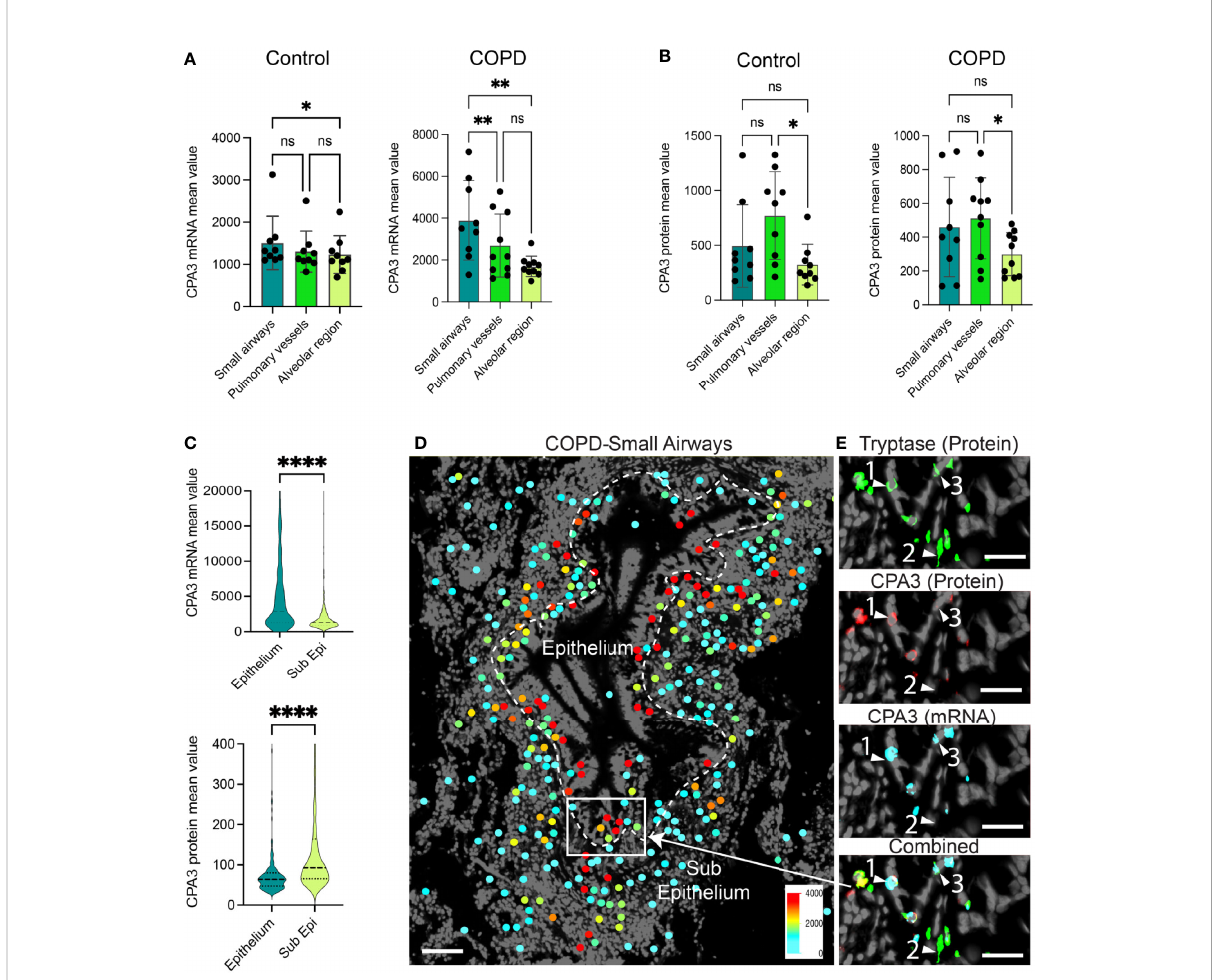
FIGURE 2 Anatomically differentiated mast cell CPA3 expression responses in COPD lungs. (A, B) Mean patient values for individual mast cell expression of CPA3 mRNA (A) and CPA3 protein (B) across anatomical lung compartments in non-diseased controls and COPD lungs. Statistical signi fi cance levels are marked as ns = non-signi fi cant, * p < 0.05, ** p < 0.01, and **** p < 0.0001. (C) Raincloud plots illustrating the difference in CPA3 mRNA and protein expression pro fi les between small airway intraepithelial and sub-epithelial small airway mast cells. (D) Zoomed-in region with a small airway where size- fi ltered mast cell coordinates have been color-coded for CPA3 level (high = red; low = turquoise). Note the foremost red CPA3 high pro fi le in the epithelial region. (E) Raw fl uorescence images of MC markers exemplifying a CPA3 mRNA+protein double-positive mast cell (label 1), CPA3 mRNA and protein double-negative cell (2), and a CPA3 mRNA-positive and protein-negative cell (3) at an epithelial – subepithelial interface. Scale bars: D = 150 m m, E = 40 m